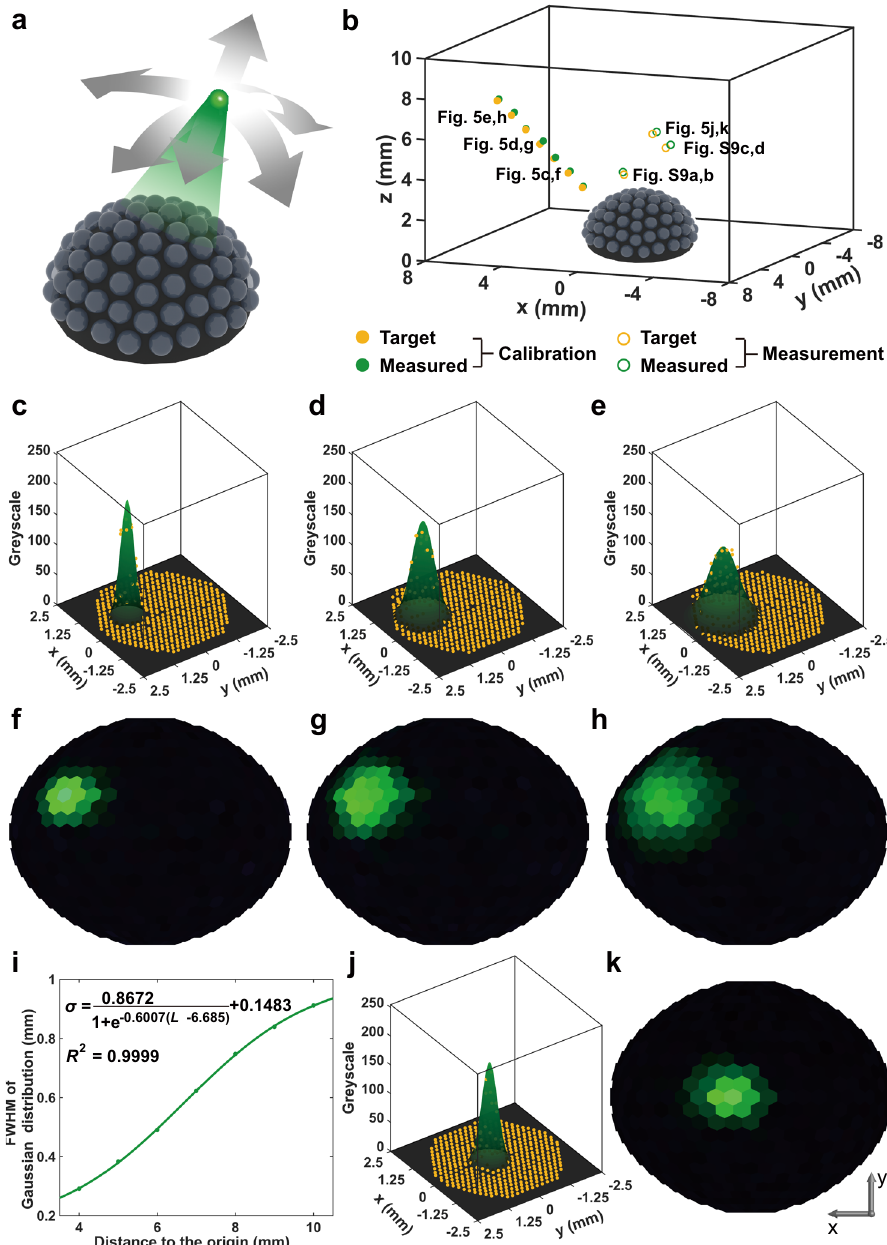
Fig. 5 Tracking the position of a light point source using the BAC-eye. a Schematic diagram of the light point source tracking experiments. b The positions of the light spots. The yellow and green solid dots are the target and measured positions used for calibration, respectively. The yellow and green circles are the target and measured positions from experiments where the light location is not known a priori. c – e The light distribution collected by the BAC-eye and f – h the corresponding hemispherical images of the light spots at a radial distance 5, 7, and 9 mm away from the original point. Yellow dots are the average grayscale measured from the proximal ends of the waveguides. The colour scale represents the intensity level of the detected light. i The relation between the full width at half maximum (FWHM) of the light distribution obtained by the BAC-eye and the distance from the original point to the light spot. j The light distribution obtained for the light spot at a nominally-unknown position and k the corresponding hemispherical images of the light Technology Co., China). The design of the pipeline structure, which acts as optical waveguides, is discussed in Supplementary Fig. 3. (7) The hemispherical substrate was inserted into the pit of the mould. The six auxiliary supports around the hemisphere of the substrate (Fig. 1g) and the six slots on the surface of the mould (Supplementary Fig. 2) were used to align the pipelines in the substrate with the microholes in the mould. (8) The entire mould plus hemispherical substrate structure was immersed into liquid-state RTV silicone (Part A: phenyl(- light for 15min to cure the acrylate resin. (6) A hemispherical substrate consisting chlorophenyl)siloxane-dimethylsiloxane copolymer, vinyldimethylsiloxane termi- of 522 hollow pipelines was designed and 3D printed using a photosensitive nated and Part B: methylhydrosiloxane-phenylmethylsiloxane copolymer, hydride polymer dyed with Sudan Black 3 (Sigma-Aldrich, USA) at a concentration of terminated; the weight ratio of Part A and Part B is 1:1) (Gelest, Inc.) and 1500 μ g/mL with the same 3D printer (nanoArch ® P140, BMF Precision